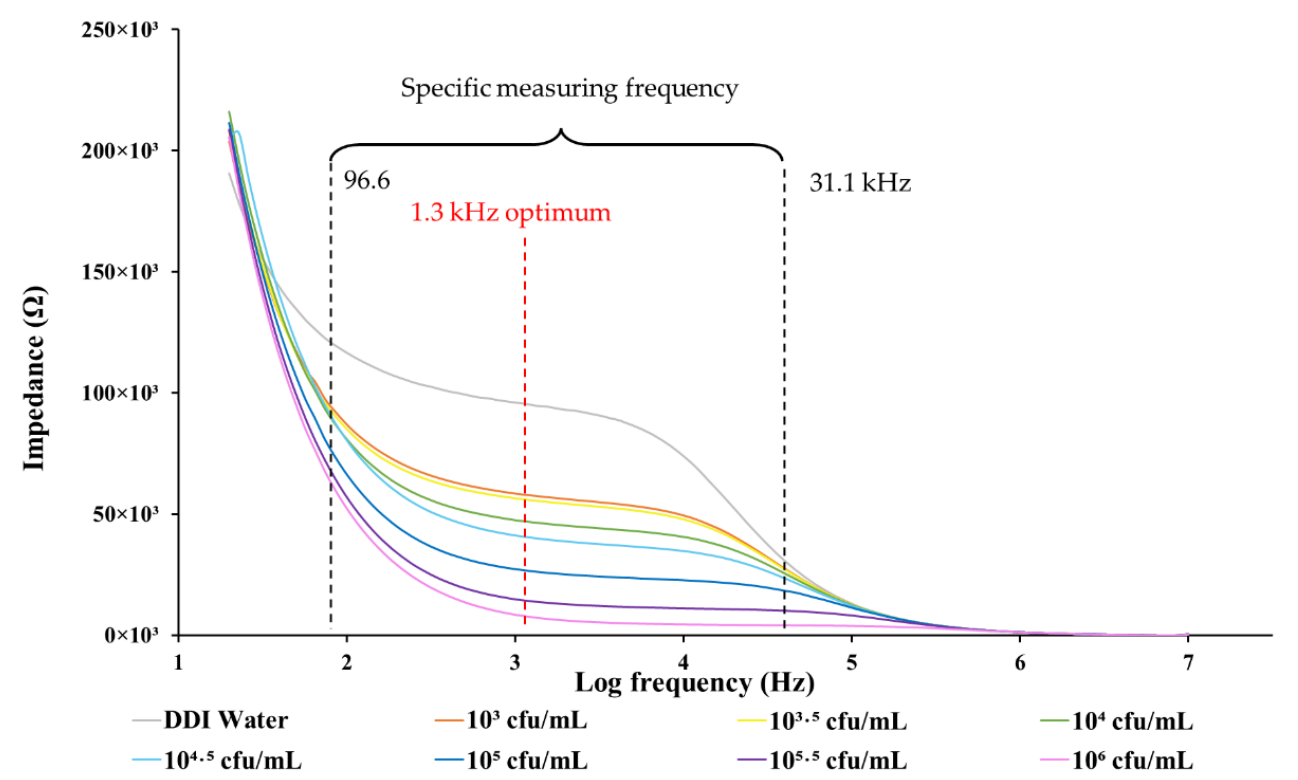
Figure 8. The spectrum of the impedance response of the IDμE sensor to various concentrations (10 3 to 10 6 cfu/mL) of E. coli samples. The optimal measurement frequency (1.3 kHz) and a specific measurement frequency range (96.6 Hz – 31.1 kHz).